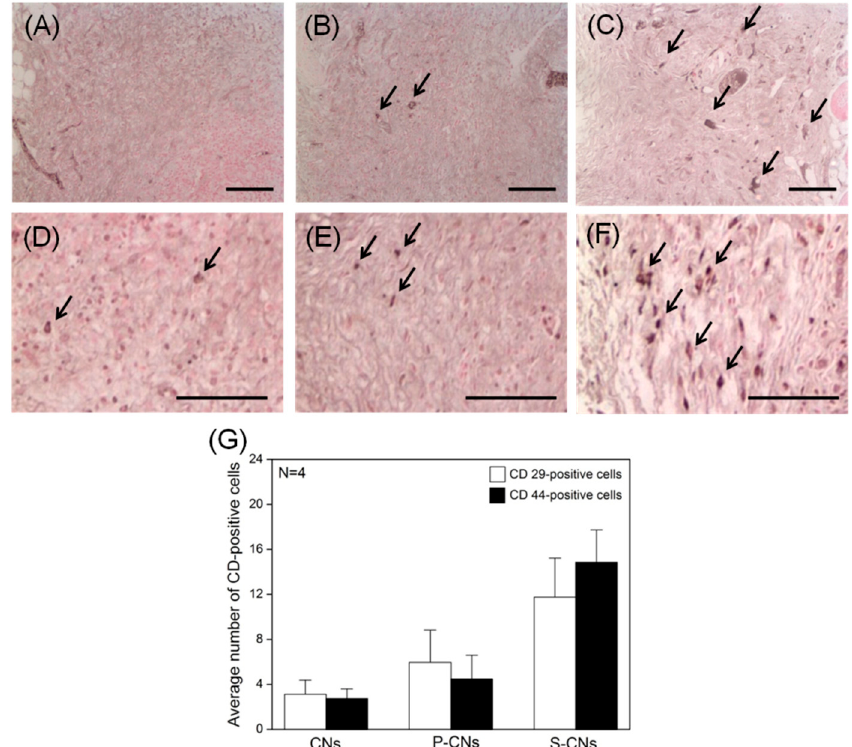
Figure 8. In vivo hMSC recruitment in CNs retrieved after one week. ( A – C ) Images showing immunohistochemical staining of CD29-positive hMSCs (dark arrows) in neutralized CNs ( A ), P-CNs ( B ) and S-CNs ( C ); ( D – F ) Images of CD44-positive hMSCs (dark arrows) in neutralized CNs ( D ), P-CNs ( E ) and S-CNs ( F ). SP-incorporated samples showed a larger number of CD29- and CD44-positive cells compared to the pristine sample. Scale bar: 100 μ m. ( G ) Quantitative analysis of CD marker-positive hMSCs from ( A – F ).